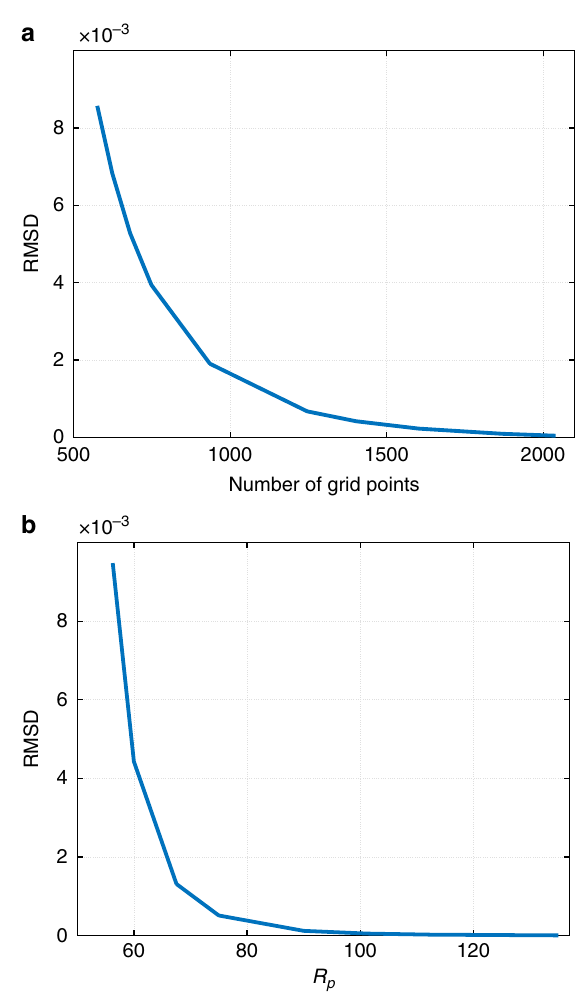
Fig. 10 Quanti fi cation of cluster ripening. The Δ g dependence of the combination ( x + y + z ) of the parameters from Eqs. (39) and (40). The two equations provide, respectively, a fi tting form for the size dependence of the volumetric growth rate and the corresponding scaling of the typical cluster size with time, at large values of the latter. Δ g is the bulk free energy excess of the minority phase per unit volume from Eq. (8). The parameter values are the same as in Fig.